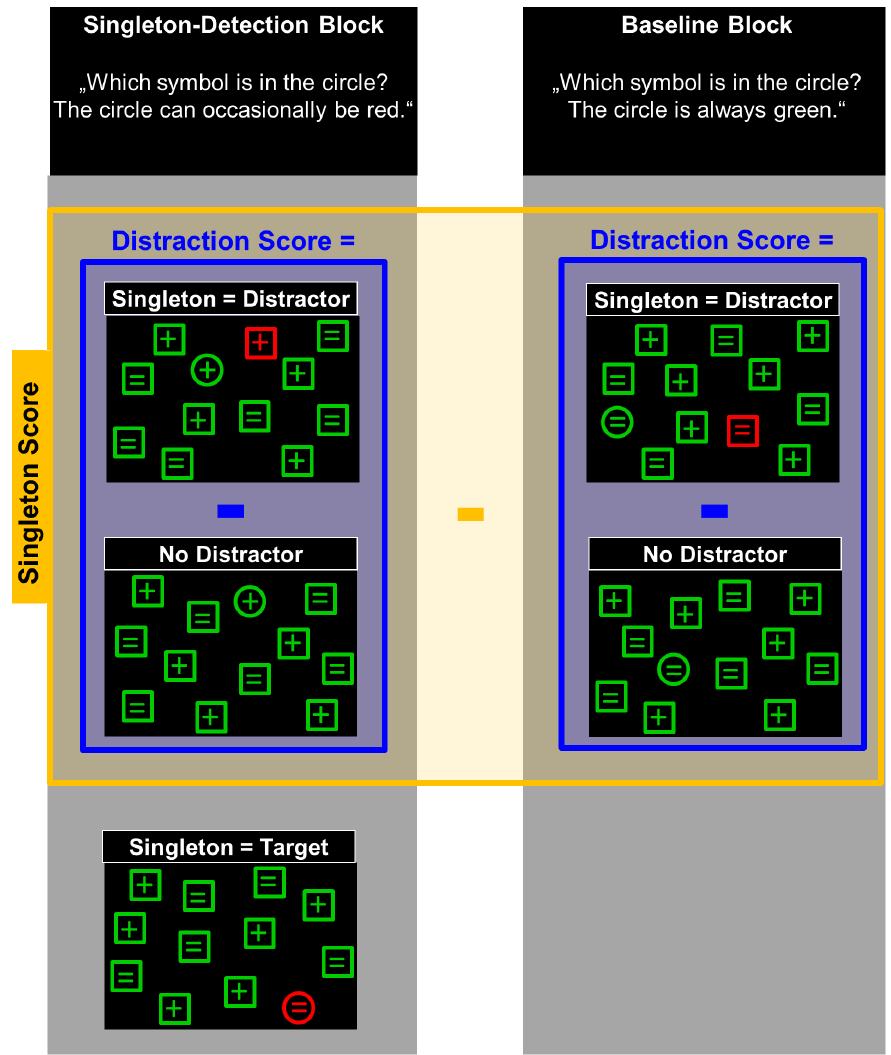
Figure 2. Illustration of the possible singleton-task conditions and of the score calculation. The left panel exemplifies the singleton- detection condition, in which the singleton distractor (red shape) can occasionally correspond to the target (circle). In the baseline condition, demonstrated in the right panel, the distractor never appears as the target. For both conditions, a distraction score (illustrated in blue) was calculated as the difference in reaction times between trials with singleton distractor and trials without distractor. Subtraction of these scores formed the singleton score (illustrated in yellow).